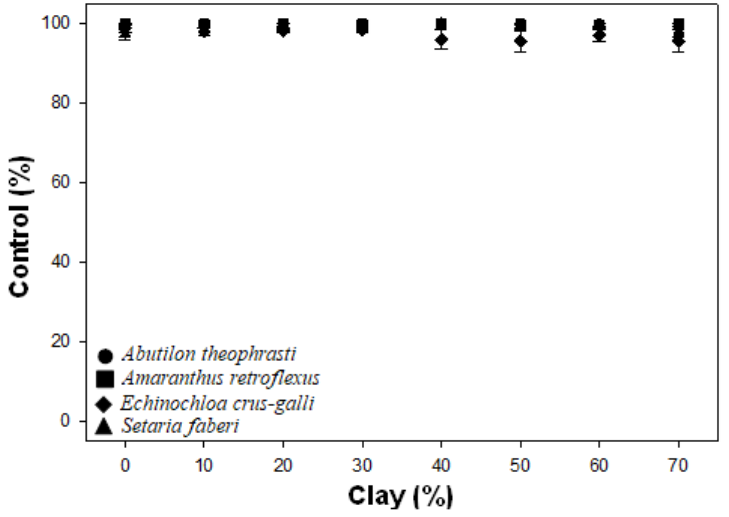
Figure 1. Control of flumioxazin on select weed species as affected by clay content. Control of flumioxazin was not affected by clay content across weed species ( p < 0.05). The vertical bars represent the standard error of means.